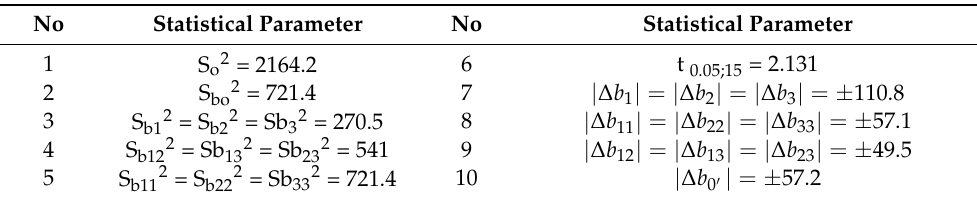
Table 2. Results of statistical processing of experimental data on nitriding Fe-ARMCO in partially dissociated ammonia atmosphere, diluted with